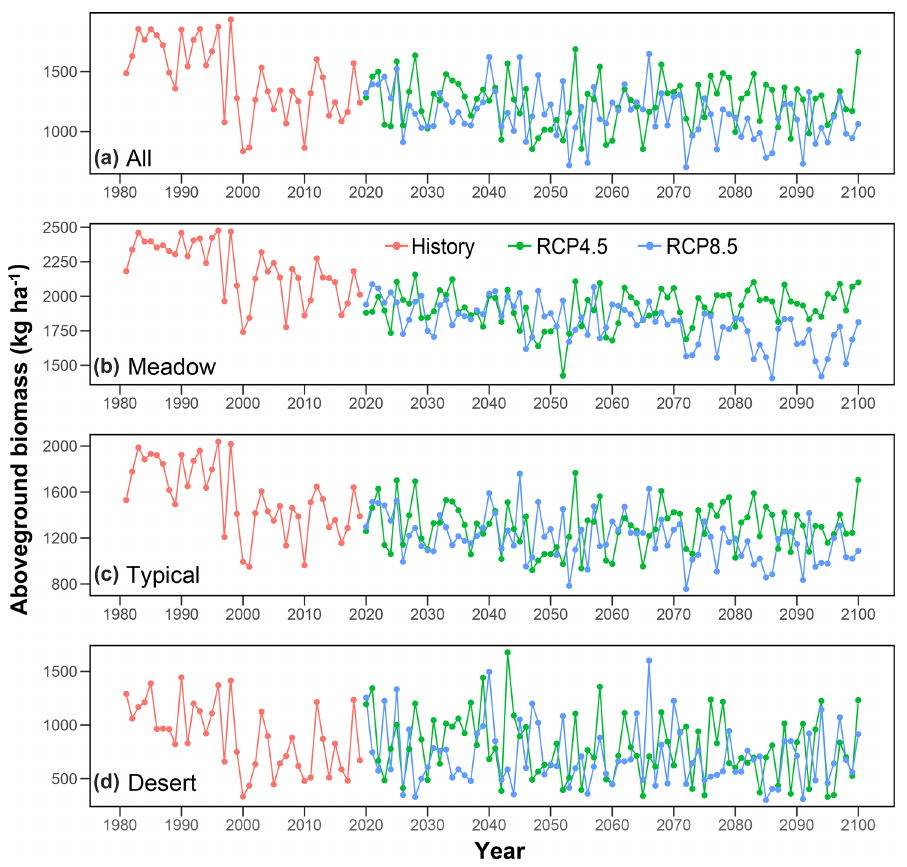
Figure 6. Temporal variations in the predicted average aboveground biomass (AGB) in Inner Mongolian grasslands. Each year, data are averages of all the 1km × 1km grids (a) and across a certain grassland type at the regional scale (b, c, d) . It should be noticed that these estimations were derived from simulations without considering the atmospheric CO 2 effects on